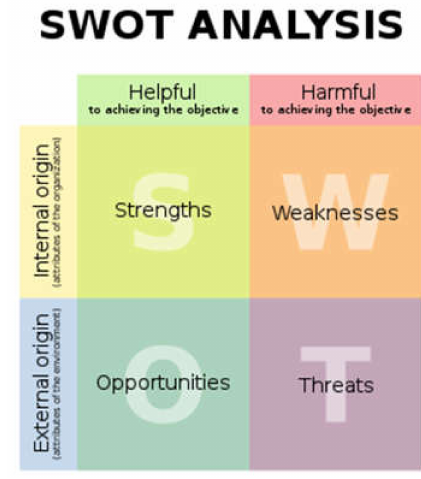
Figure 2. Illustrative diagram of a SWOT (strengths, weaknesses, opportunities, and threats)